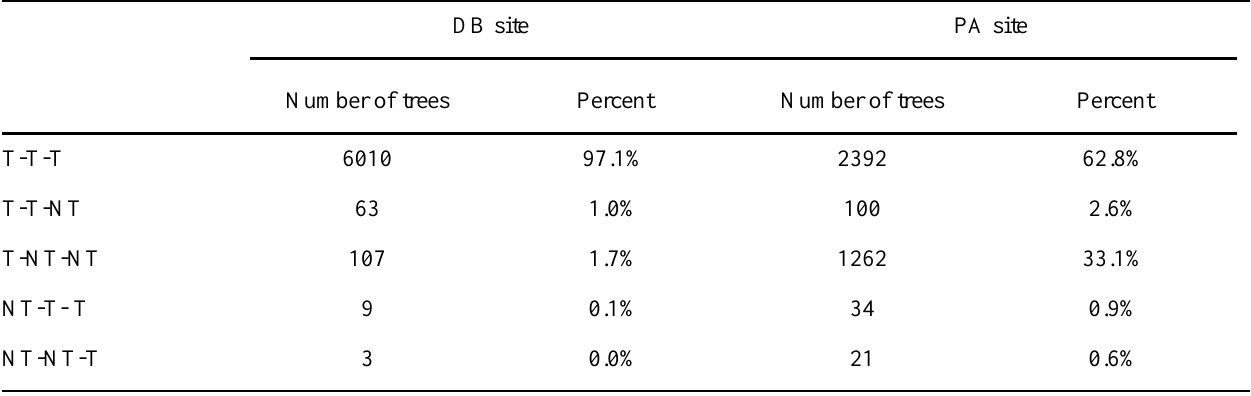
Table 2 . Distribution of change categories. T stands for “visible tree,” and NT stands for “tree missing.” The DB site is the Dehesa Boyal site, and the PA site is the Parapuños de Doña María site.. DB site PA site Number of trees Percent Number of trees Percent 97.1%